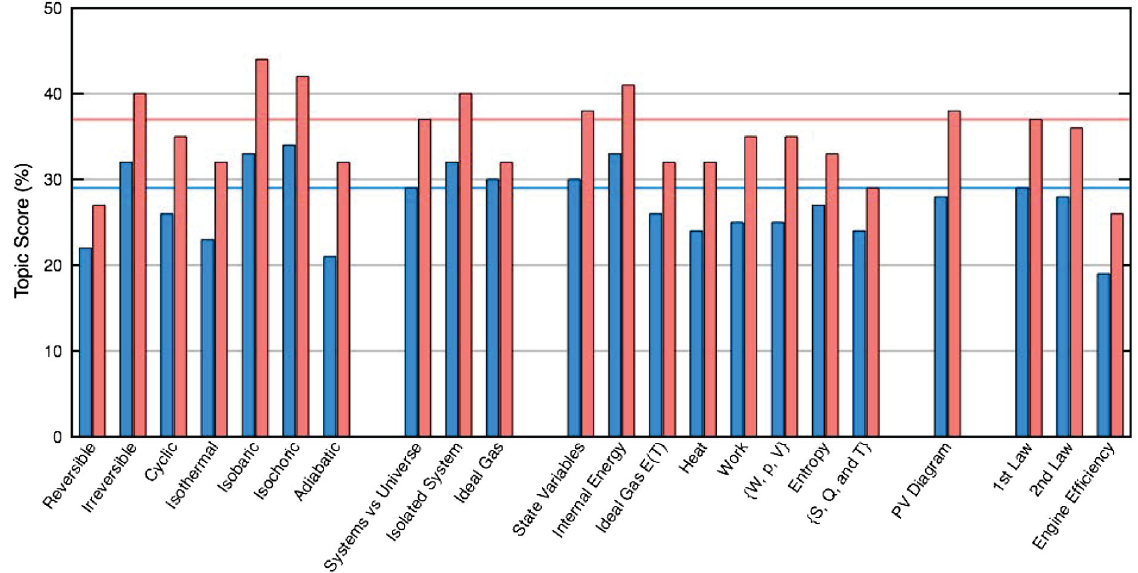
FIG. 4. Average percentage scores for students in calculus-based introductory physics courses on the STPFaSL instrument by topic before and after instruction (for the pretest, the number of students N ¼ 704 , blue, and for the post-test, N ¼ 505 , red). The blue and red horizontal lines show the averages on the entire survey instrument before and after instruction,